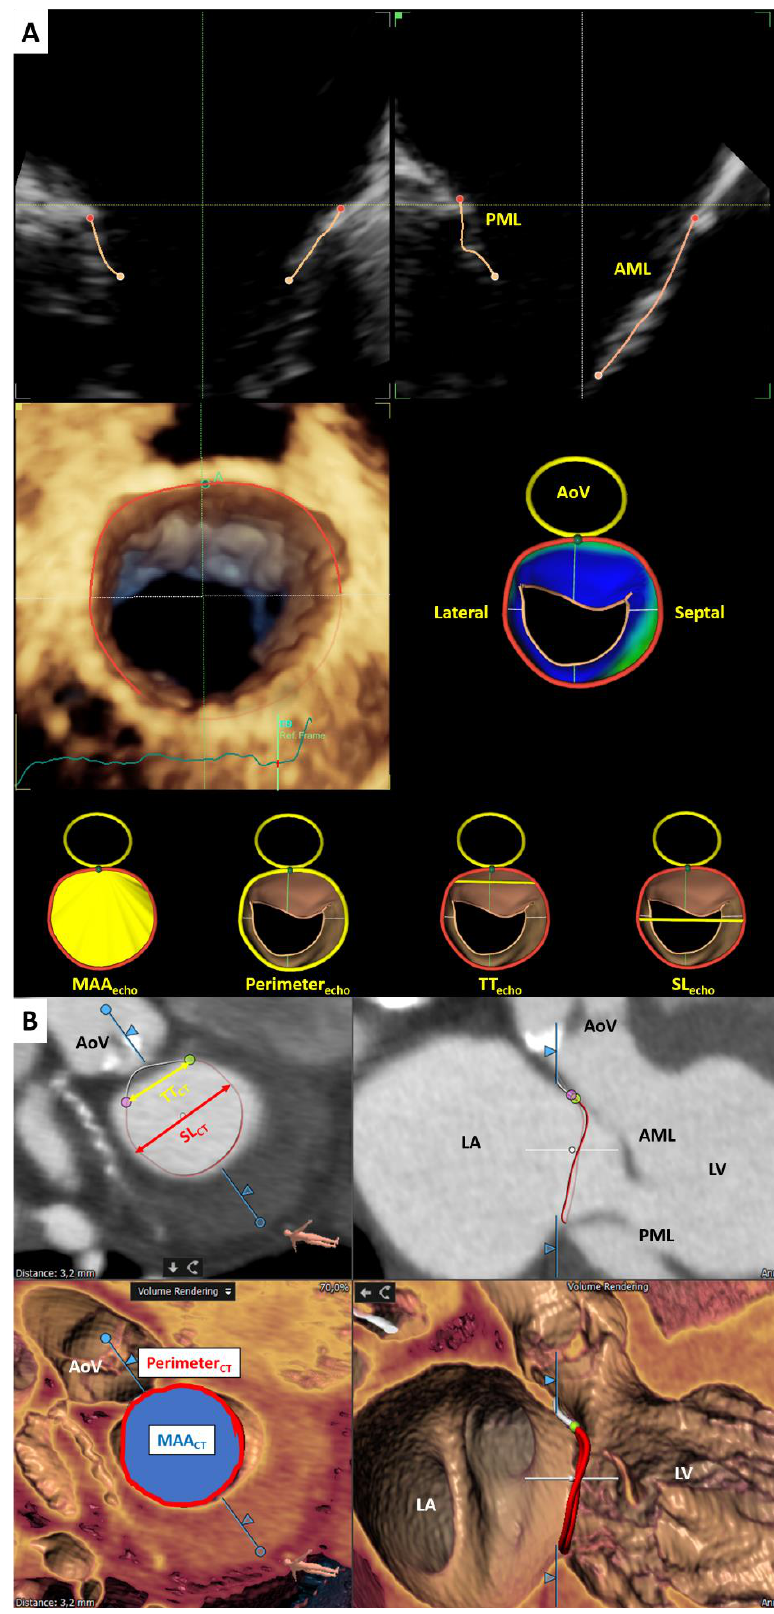
Figure 1. Assessment of mitral annular geometry using ( A ) 3D TEE and ( B ) MDCT. AoV = aortic valve; AML = anterior mitral leaflet; LA = left atrium; LV = left ventricle; MAA = mitral annular area; PML = posterior mitral leaflet; SL = septal-lateral distance; TT = inter-trigonal distance.